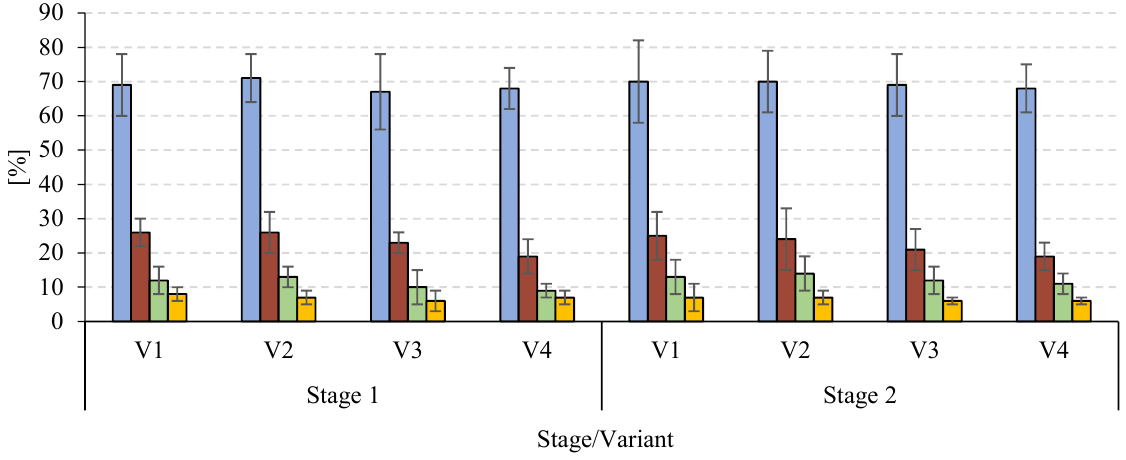
Figure 8. Anaerobic bacterial community composition in particular experimental variants.